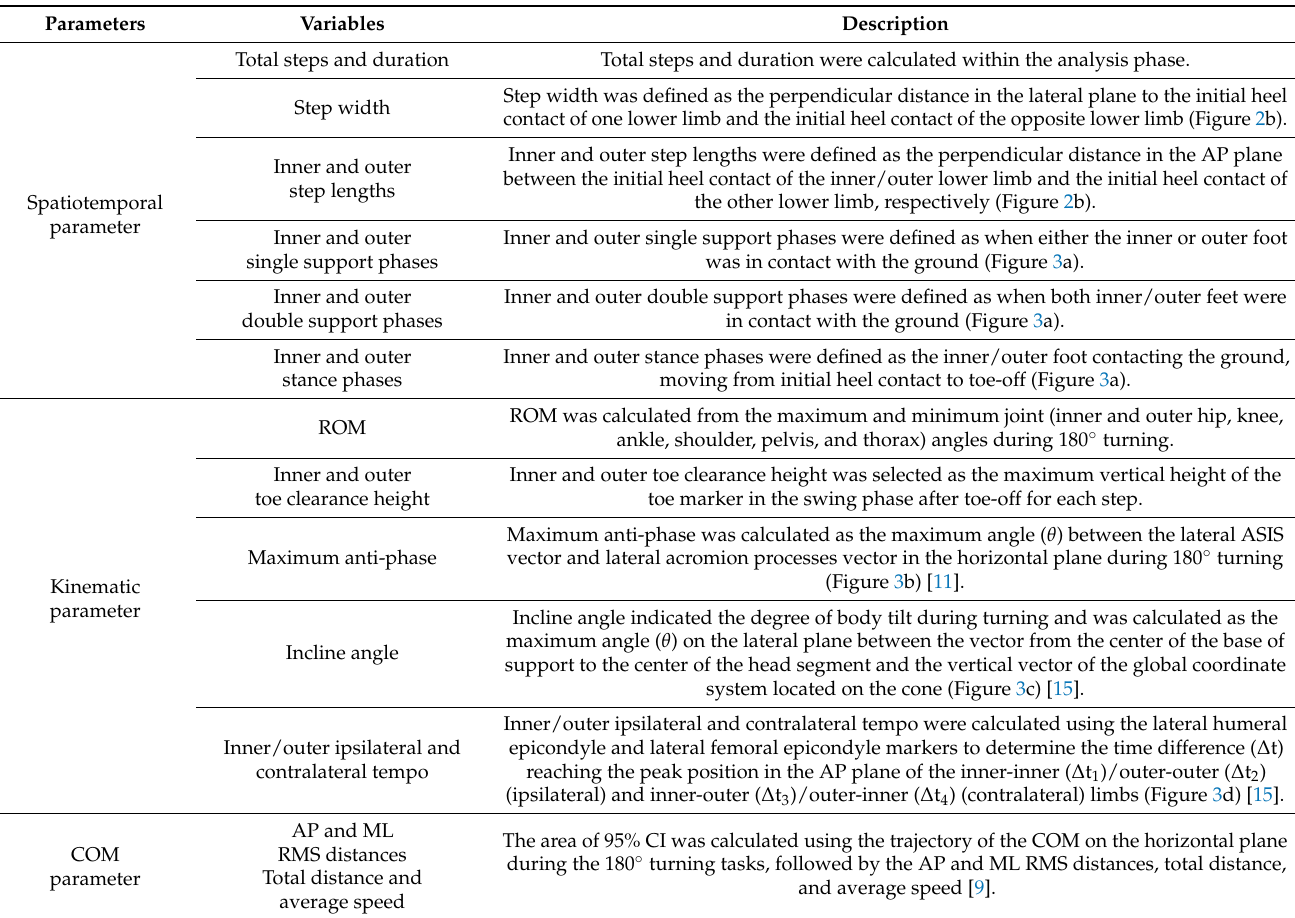
Table 2. List of variables and their definitions used for